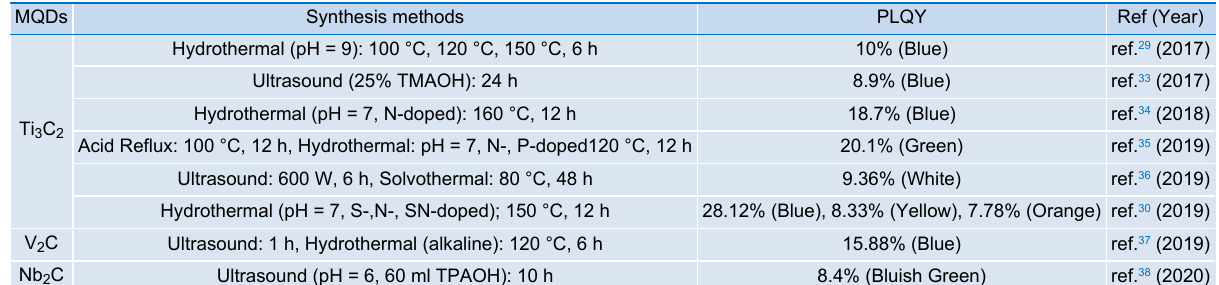
Table 1 | Current progress on MQDs exhibiting photoluminescence MQDs Synthesis